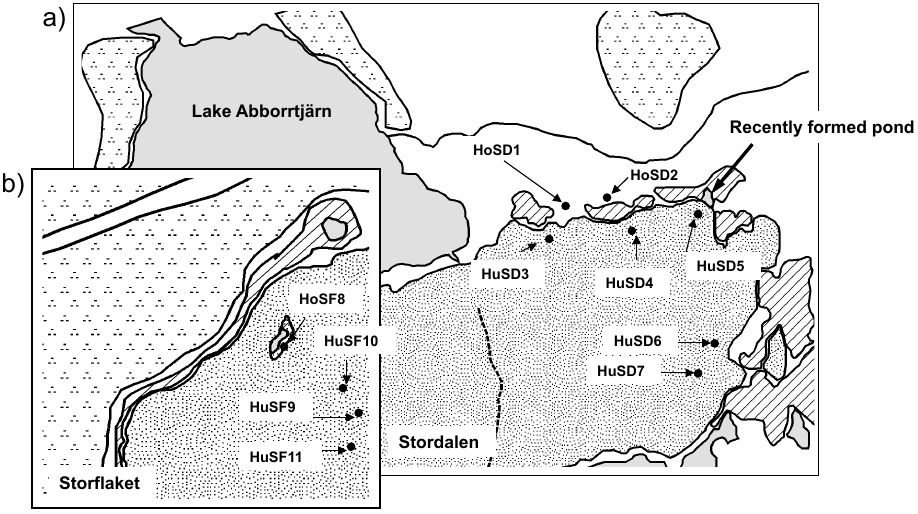
Fig. 2. Map showing the coring sites at (a) Stordalen and (b) Storflaket mires. Cores are labelled Ho = Hollow, Hu = Hummock, SD=Stordalen, SF=Storflaket and in ascending order from 1 to 11 according to the sampling sequence.